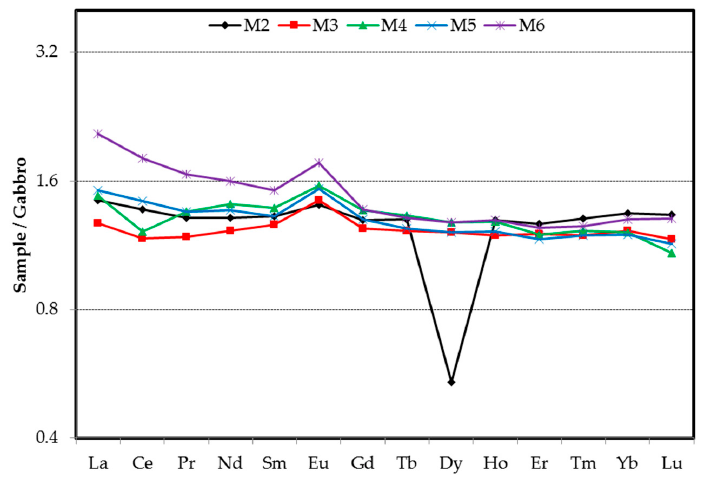
Figure 7. Gabbro-normalized rare-earth element patterns of the profile samples.